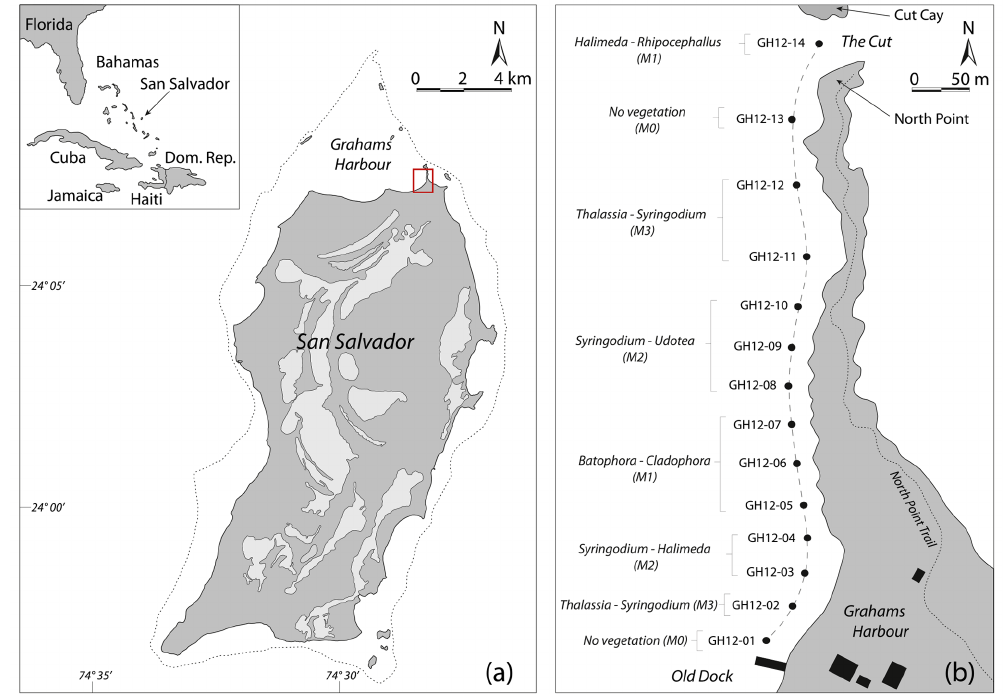
Figure 1. (a) Map of the Bahamas in the western North Atlantic Ocean and location map of San Salvador; modified after Robinson and Davis (1999). Light grey areas: distribution of fresh and saltwater lakes on San Salvador. The dotted line indicates water depths less than 10m. Red square: study area at Grahams Harbour. (b) Schematic map of the studied transect (dashed line) with 14 sample sites from the Old Dock (site GH12-01) to the Cut (site GH12-14), with a water depth of approx. 1m. The sample sites are categorized into microhabitats M0 (vegetation absent), M1 (sparse vegetation), M2 (moderate vegetation) and M3 (dense vegetation) in accordance with the dominant macrophyte species in the respective habitats. Black rectangles indicate the location of building